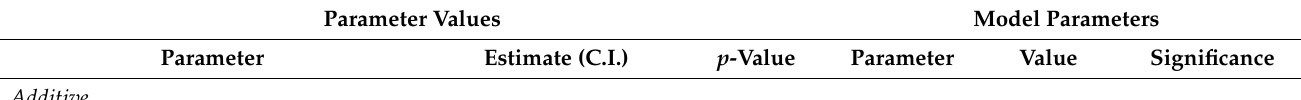
Table 6. Multivariate Geospatial Analysis for Spina